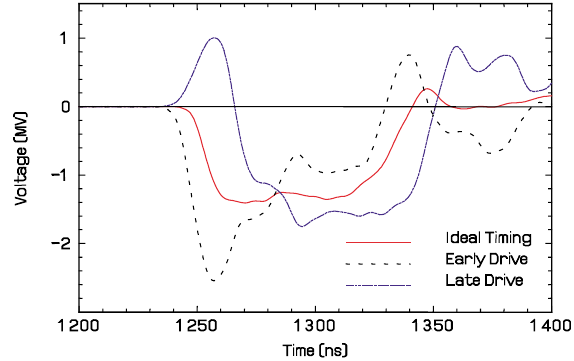
FIG. 29. (Color) Insulator voltage waveforms for ideal switch timings and 95th percentile worst-case timing for early and late driven